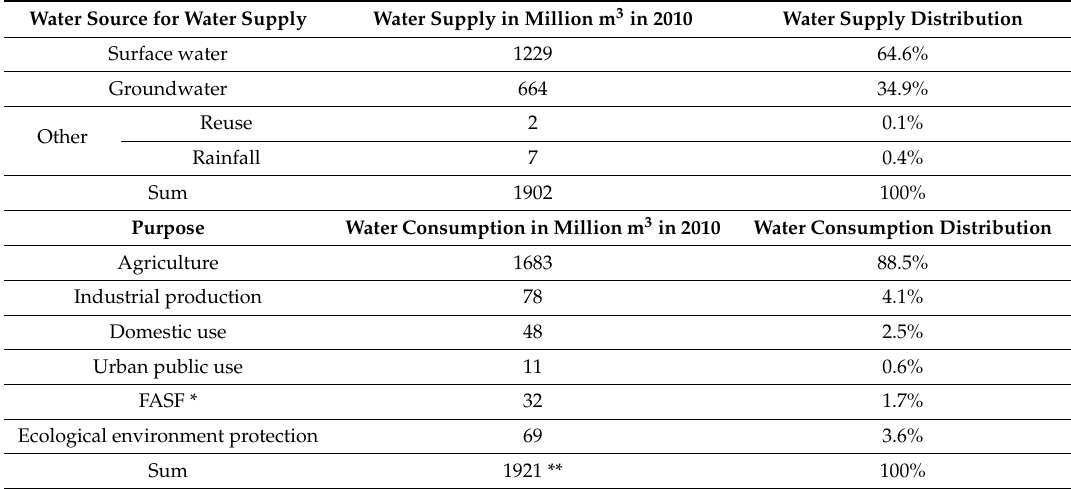
Table 2. Water balance in 2010 for Wuwei (Source: own table, data according to